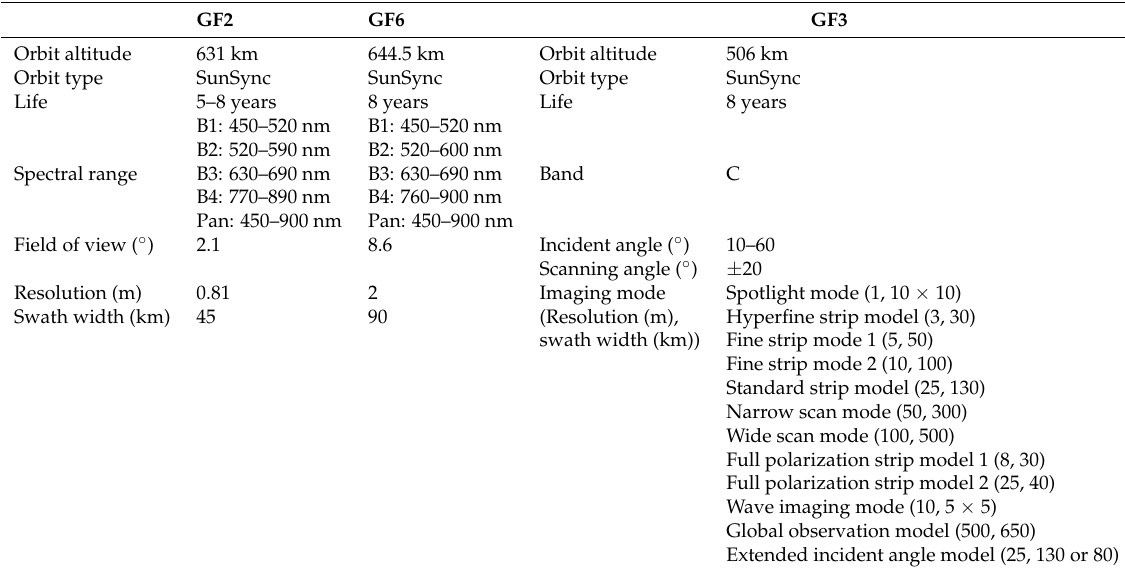
Table 3. Satellite parameters of GF2, GF6, and GF3.